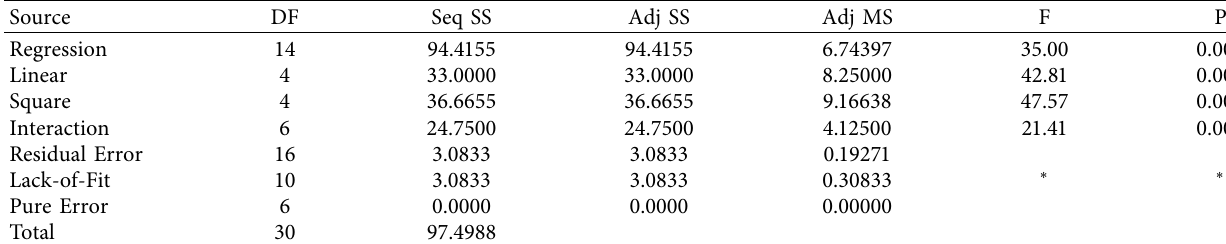
Table 5: ANOVA for TWR